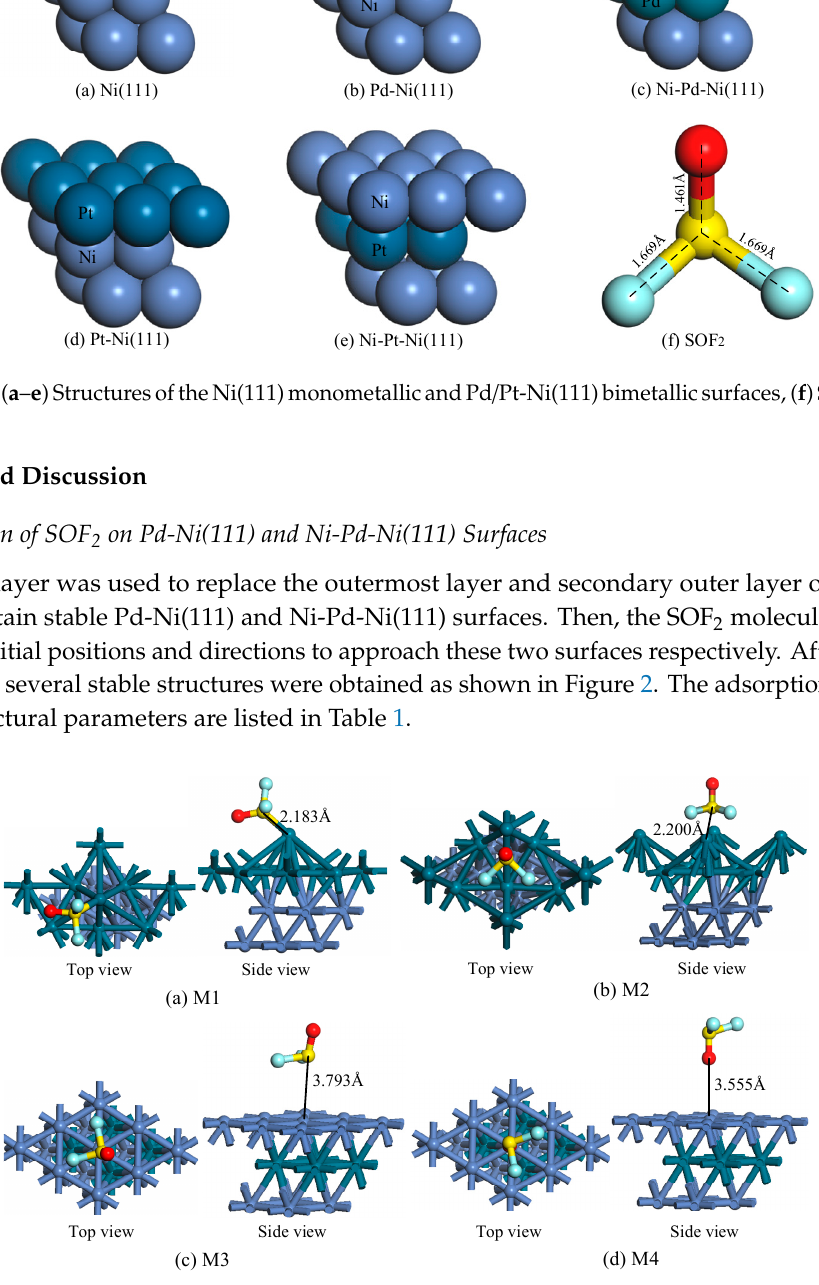
Figure 2. The top and side views of adsorption structures. ( a , b ) SOF 2 adsorption on Pd-Ni(111) surface for M1 and M2 structures, ( c , d ) SOF 2 adsorption on Ni-Pd-Ni(111) surface for M3-M4